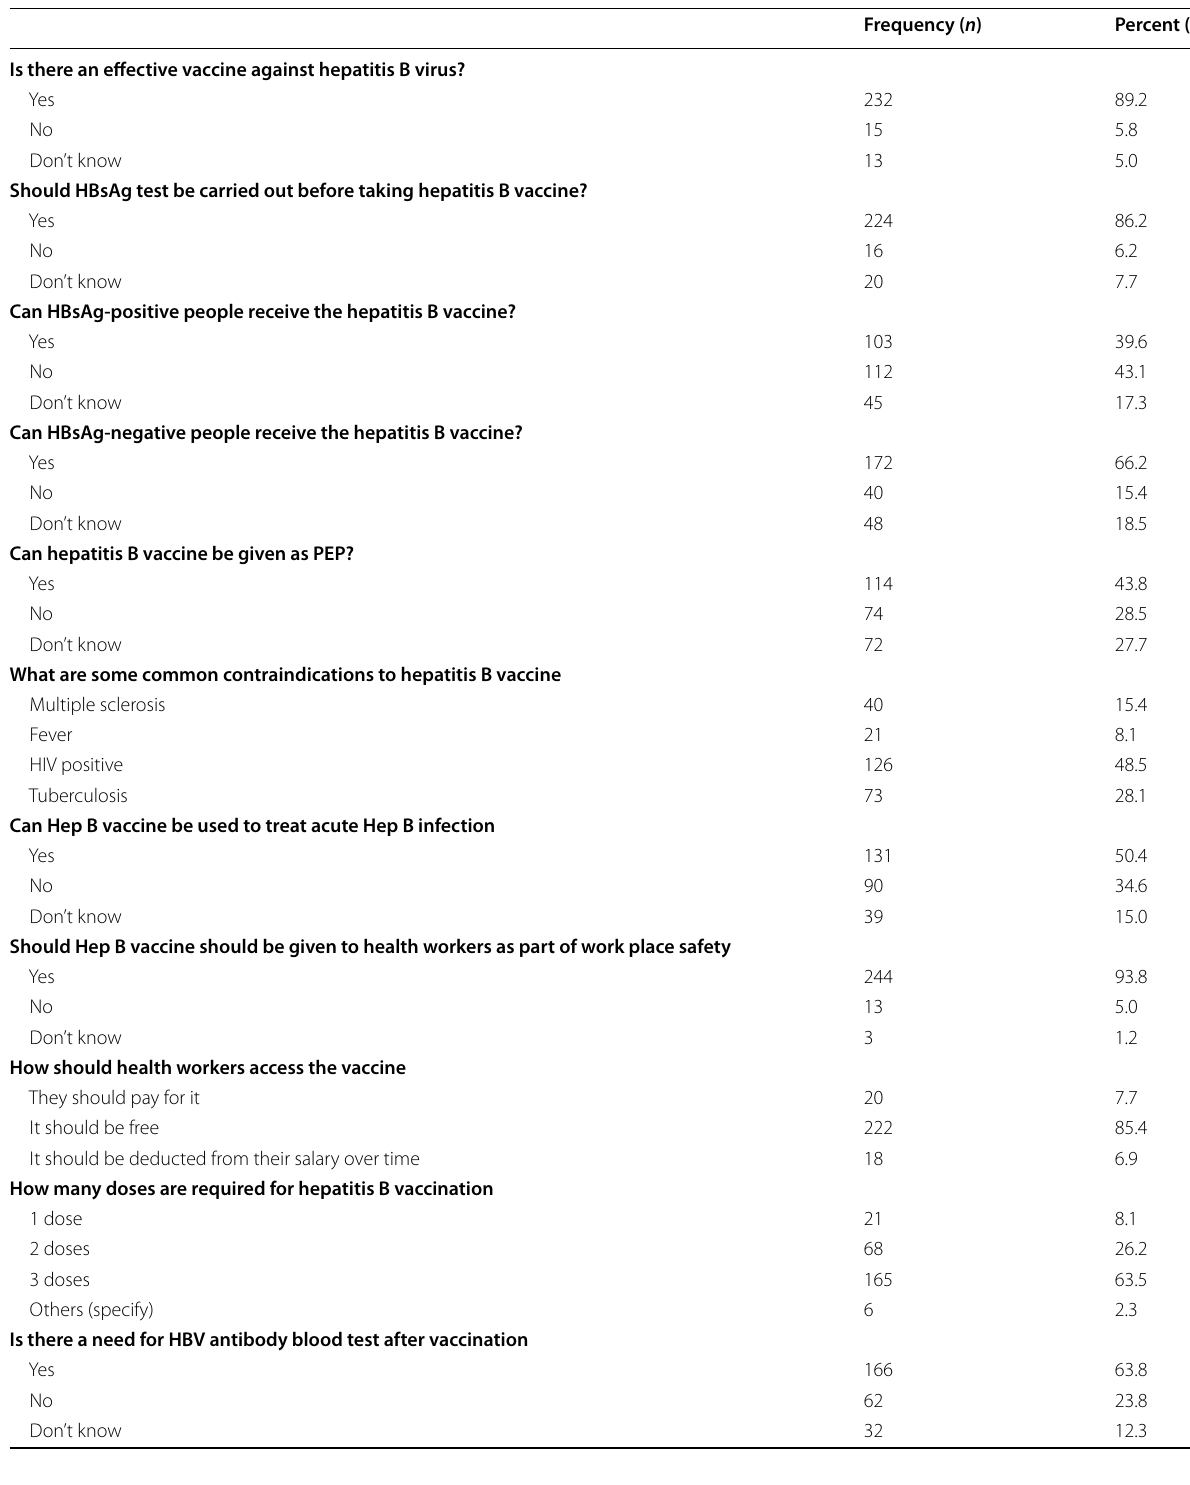
Table 2 Knowledge, perception, and attitude towards hepatitis B vaccination ( N